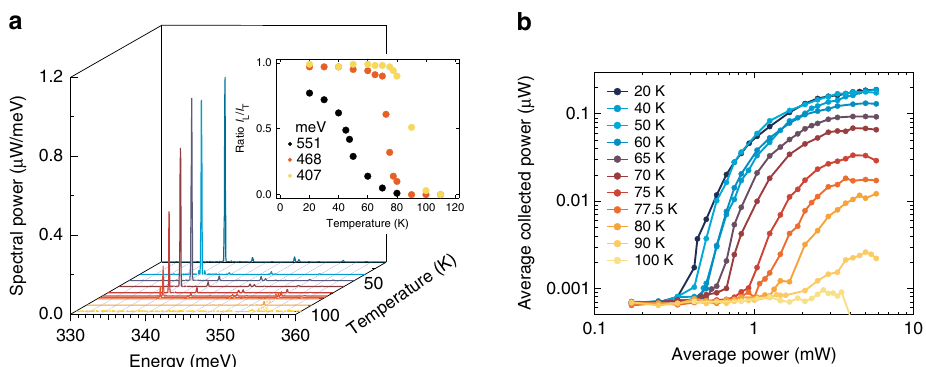
Fig. 3 Temperature dependence of the strained Ge laser. a Lasing spectra of a L5 microbridge between 20 and 100 K, at 2.91 mW excitation power and 407 meV excitation energy, highlighting the fast decrease of the main lasing mode at 338 meV around 80 K. A spurious signal from the excitation laser at 352 meV is eliminated from the traces, for convenience. Raw data is given in the Supplementary Note 7. Inset: Ratio between all the lasing modes intensity ( I L ) and the total intensity ( I T ) for L5 as a function of the temperature for three different excitation energies. b Power emitted from the L5 samples as a function of the excitation power, for